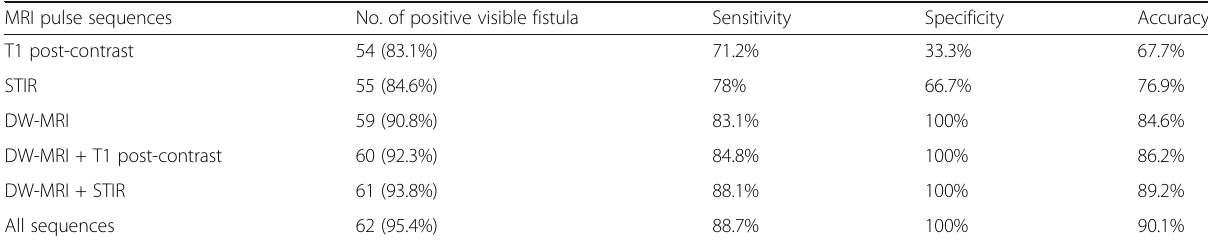
Table 4 Visibility of PAF using different MRI pulse sequences MRI pulse